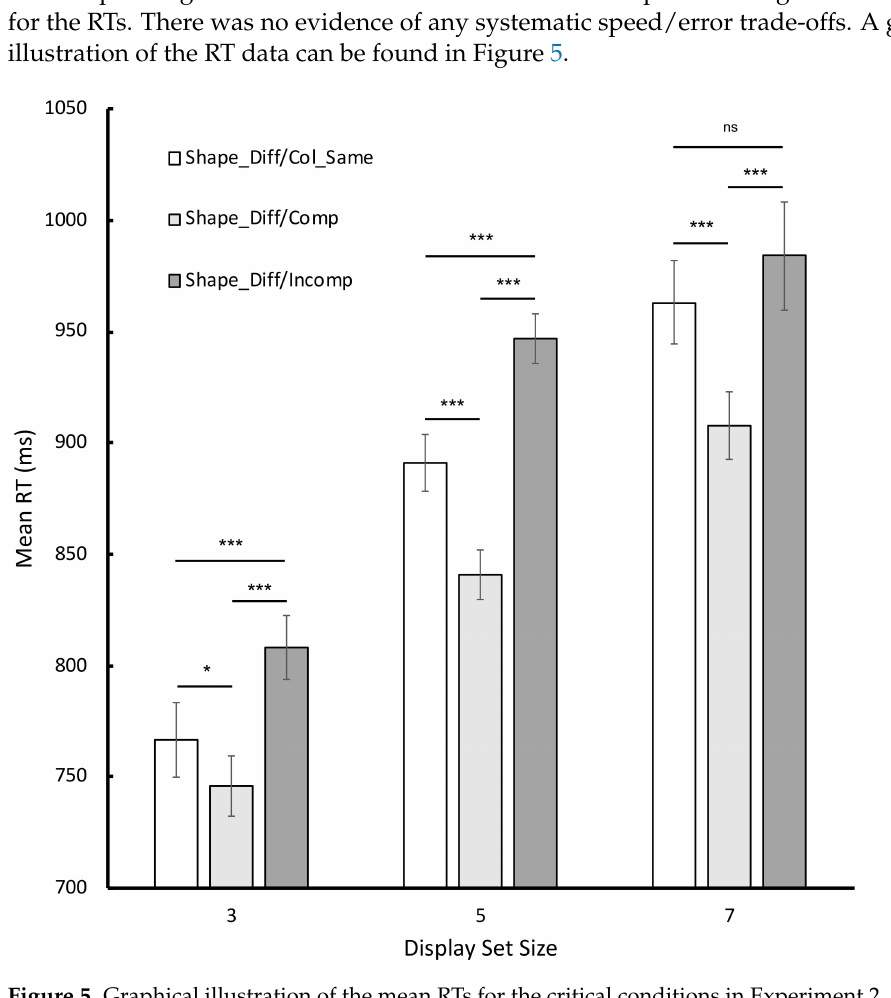
Figure 5. Graphical illustration of the mean RTs for the critical conditions in Experiment 2. Error bars reflect 95% CIs as recommended by Bakeman and McArthur [14]. ns signifies not statistically reliable at the 0.05 level; *** signifies p <0.001; * signifies p < 0.05 (Bonferroni